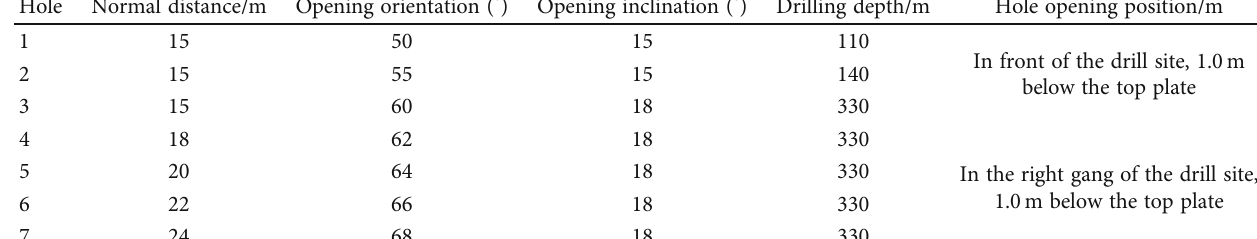
Table 3: Table of high drilling parameters.